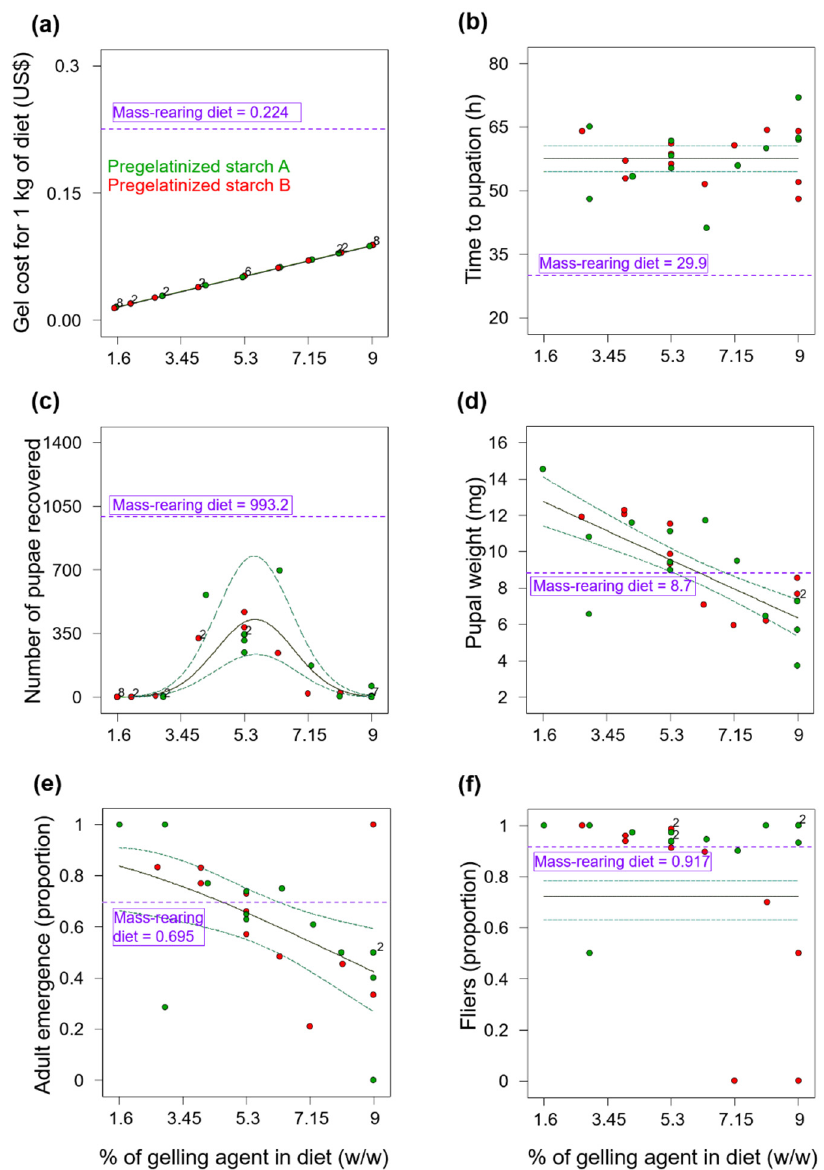
Figure 1. Polynomial models fitted to data on ( a ) gels costs, ( b ) time to pupation, ( c ) number of larvae recovered, ( d ) pupal weight, ( e ) adult emergence and ( f ) flight ability (fliers) of Anastrepha ludens as a function of the type of gelling agent (pregelatinized starch A and B) and its percentage in a yeast-reduced larval gel diet. The circles indicate the data points and the solid line the model fitted to data with 95% CI. The horizontal purple dotted line in each figure panel indicates the mean value (n = 4) observed in the mass-rearing diet, which in the case of panel (a) indicates the cost of the amount of corncob powder in 1 kg of diet.